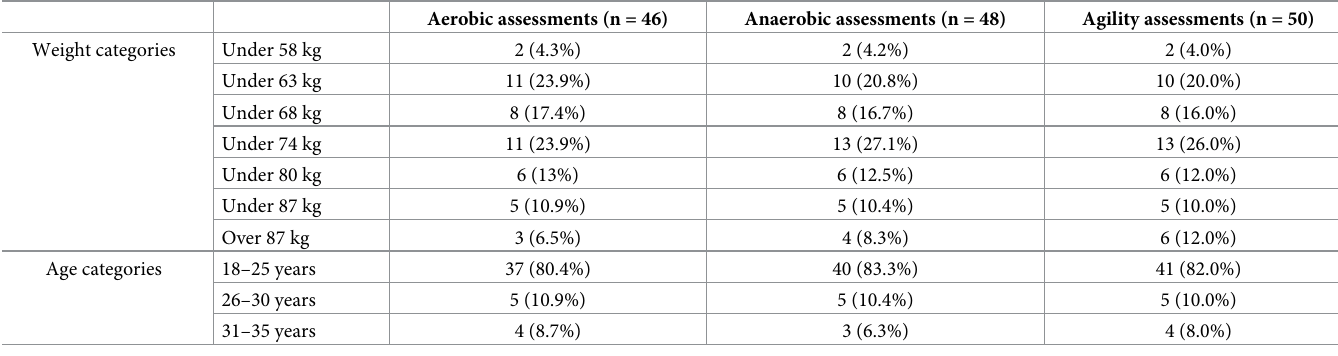
Table 2. The distribution of athletes in different weight and age categories �